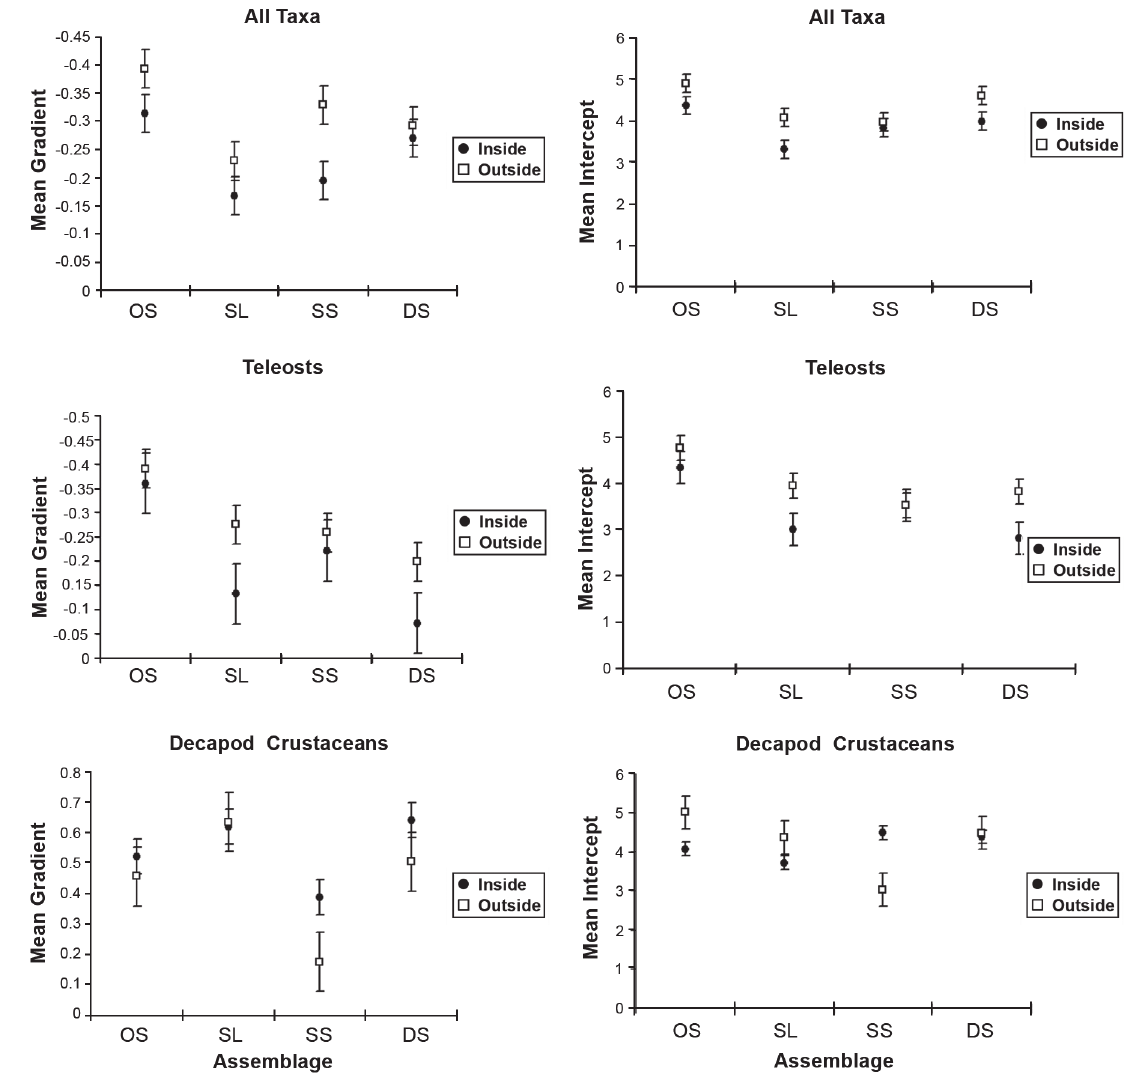
Fig 5. – Variation in the slopes and intercept (± 1 S.E.) of the biomass size-spectra for the different taxonomic groups, by assemblage type, and inside and outside the Maltese 25 Nautical Mile Fisheries Management Zone. OS, Outer Shelf; SS, Shelf Break; SL, Shallow Slope; DS, Deep